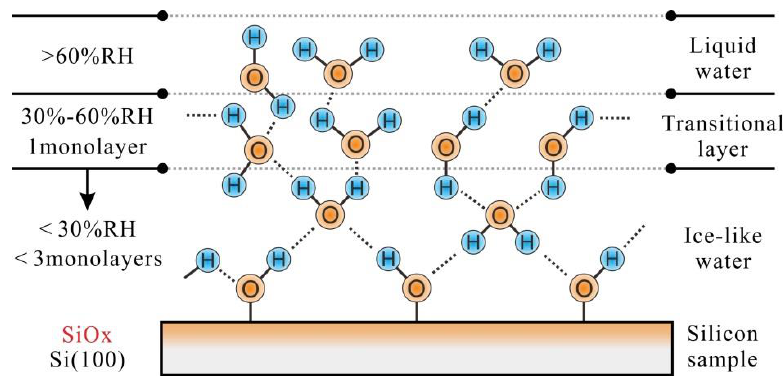
Figure 6. Water structure formed on silicon sample surface at various RHs.